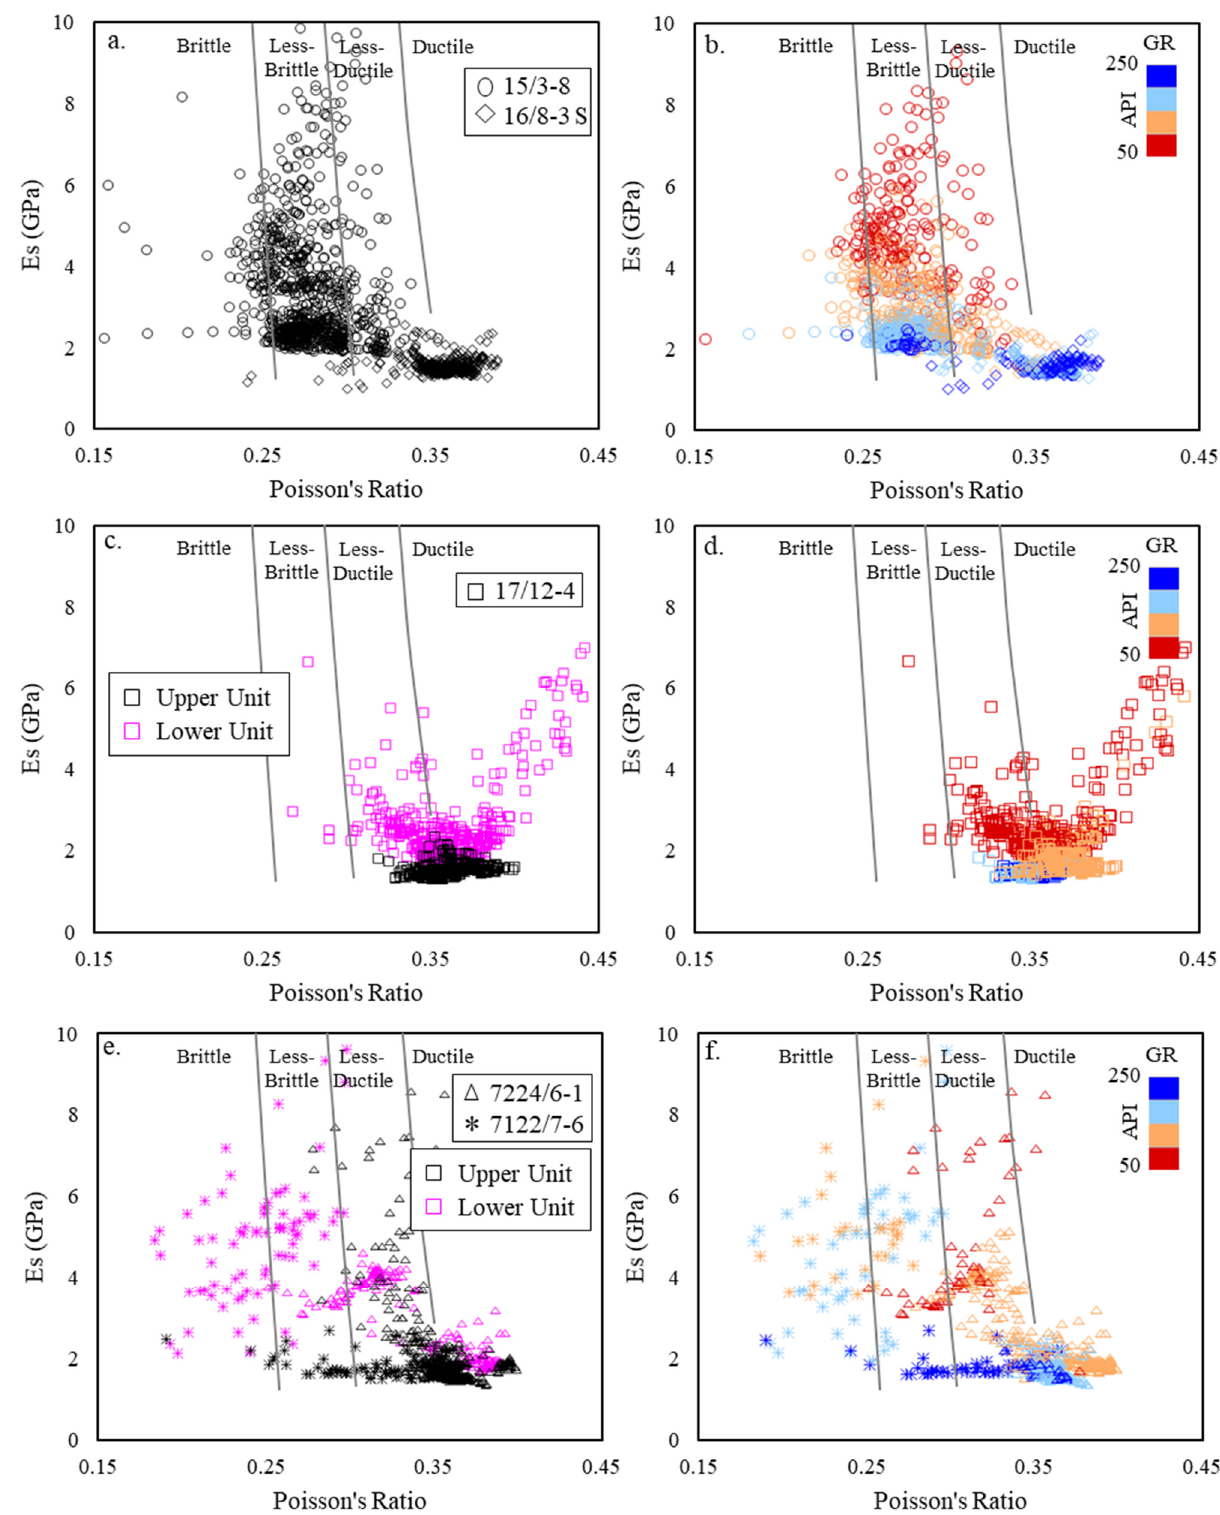
Figure 7. E s versus ν cross-plots of upper (Draupne, Hekkingen & Tau formations) and lower (Fuglen & Egersund formations) units from different Basins color coded with formations ( a , c , e ), GR ( b , d , f ). The reference BI zone boundaries (RPT) are adapted from Perez and Marfurt [67].